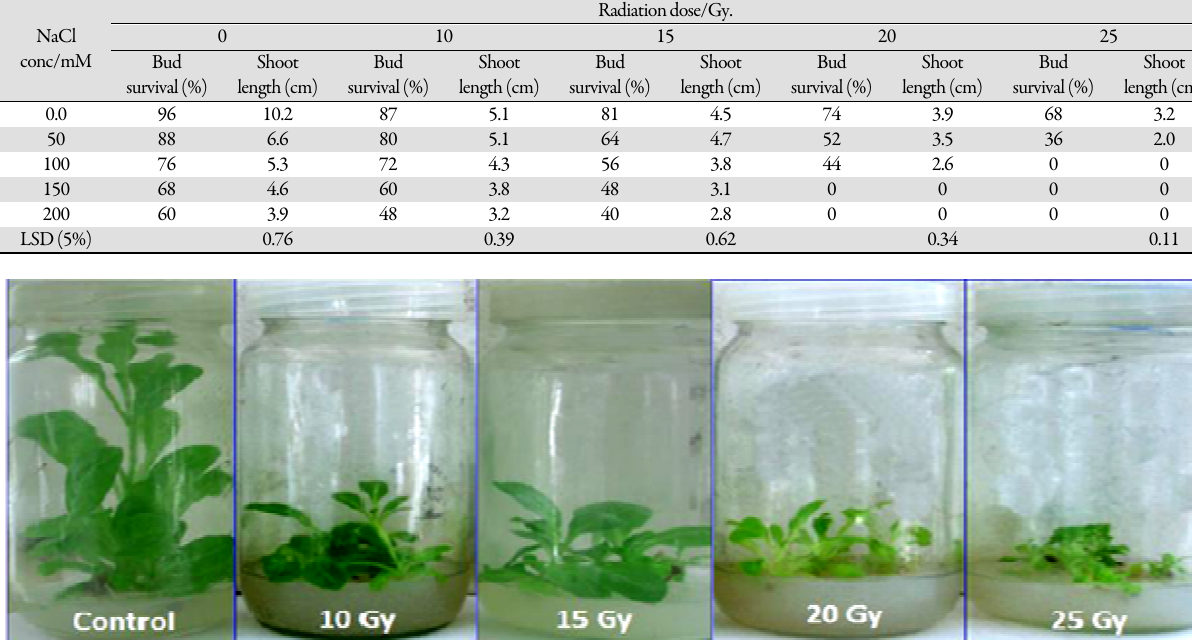
Radiation dose/Gy.